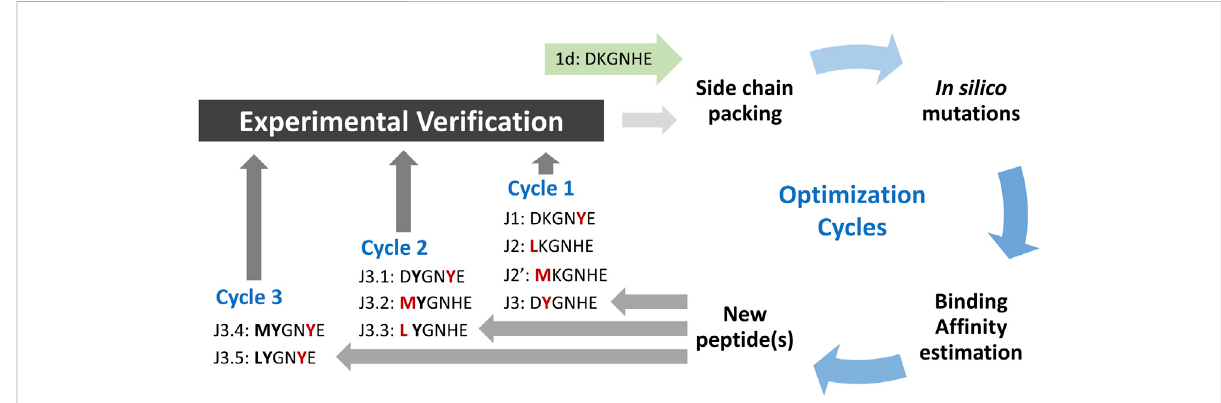
FIGURE 1 Schemeofpeptideligandsoptimizationprocedure.Theaminoacidresidueswithmostfavoredchangesin Δ G bind foreachrunareshowninred, and bold fonts represent the advantageous mutation(s) adopted from the previous run.